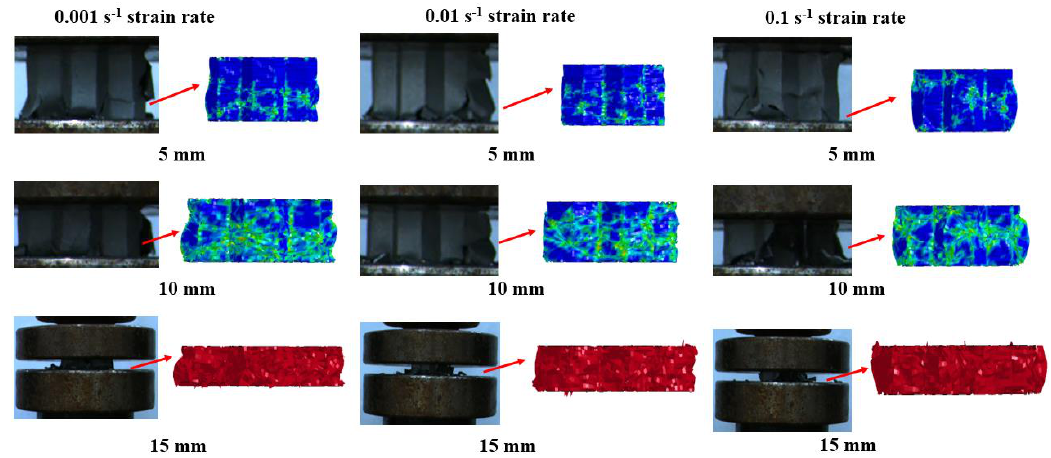
Figure 7. The crushing process of BHTS – S under various strain rate loading.